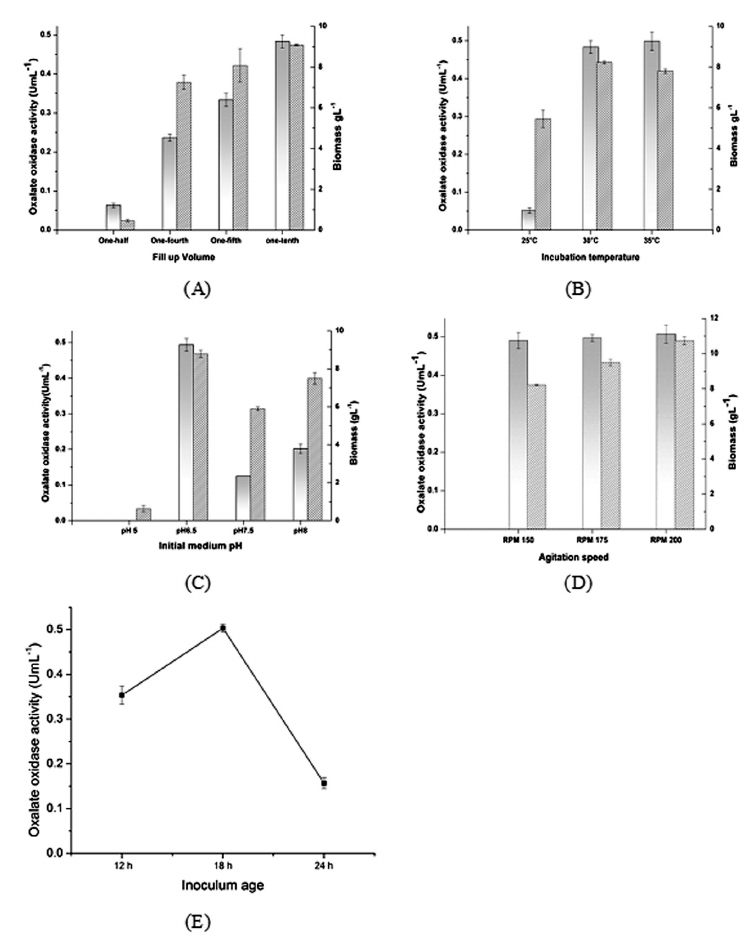
Fig. 3. Effect of non-nutritional parameters on biomass growth and enzyme production.(A) Effect of fill up volume on the biomass growth () and oxalate oxidase activity () was studied in a medium having 20 gL -1 of sucrose, 5 gL -1 sodium oxalate and 2 gL -1 NH Cl along with basal salts. While finding the effect of fill up volume, MnSO concentration 4 4 of 0.05 gL -1 was taken in the medium. (B) Effect of fermentation temperature on biomass growth and enzyme production. Fill up volume of one-tenth was maintained for all the experiments. Biomass content at peak enzyme activity was considered. (C) Effect of initial medium pH on enzyme production was studied with medium having 20 gL -1 of sucrose, 5 gL -1 sodium oxalate and 2 gL -1 NH Cl, 0.05 gL -1 MnSO along with basal salts. Experiments were 4 4 conducted at 30°C, fill up volume of one-tenth, agitation rate of 150 rpm and initial medium pH of 6.5. (D) Effect of agitation speed (E) Effect of inoculum